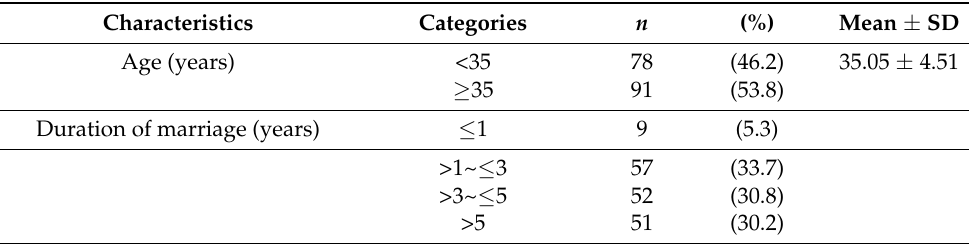
Table 1. General characteristics of subjects ( n =